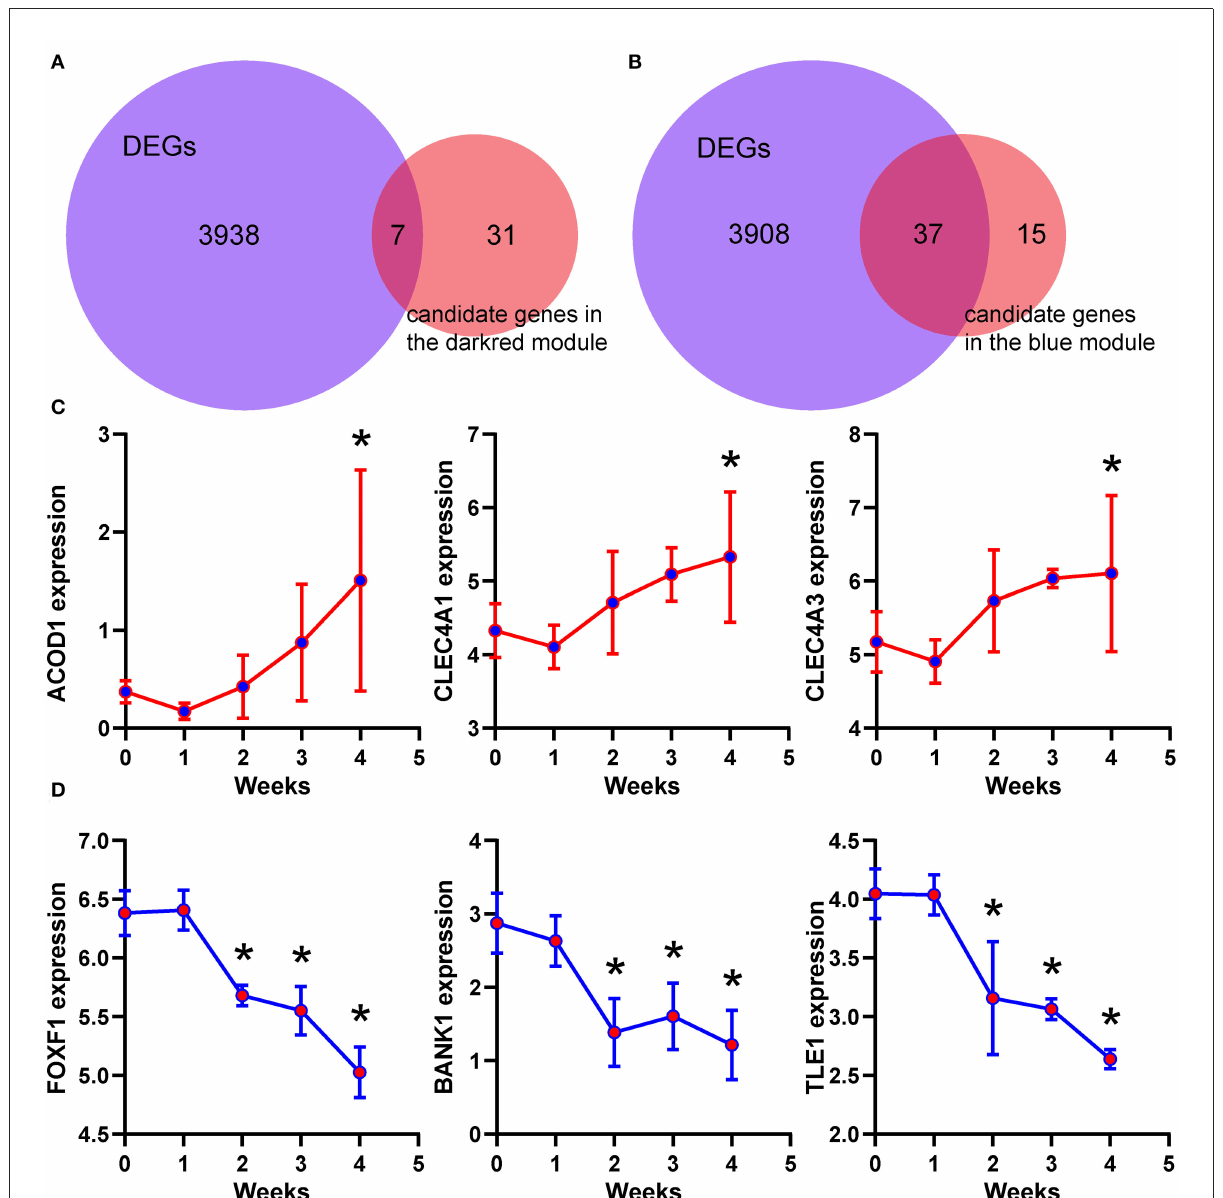
FIGURE7 Identification of the hub genes. (A,B) Venn diagram showing the overlapped gene numbers between differentially expressed genes and candidate genes. (C,D) Temporal expression levels of six hub genes. Data are shown as mean ± S.E.M. n = 3 MCT-treated rats at each week, and n = 5 control. * P < 0.05 vs.